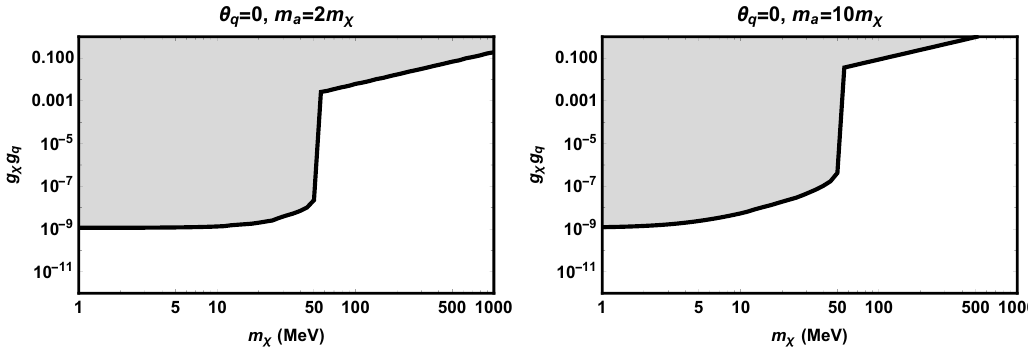
Figure 3 . The 90% CL upper bounds on g χ g q as a function of the mass m χ from